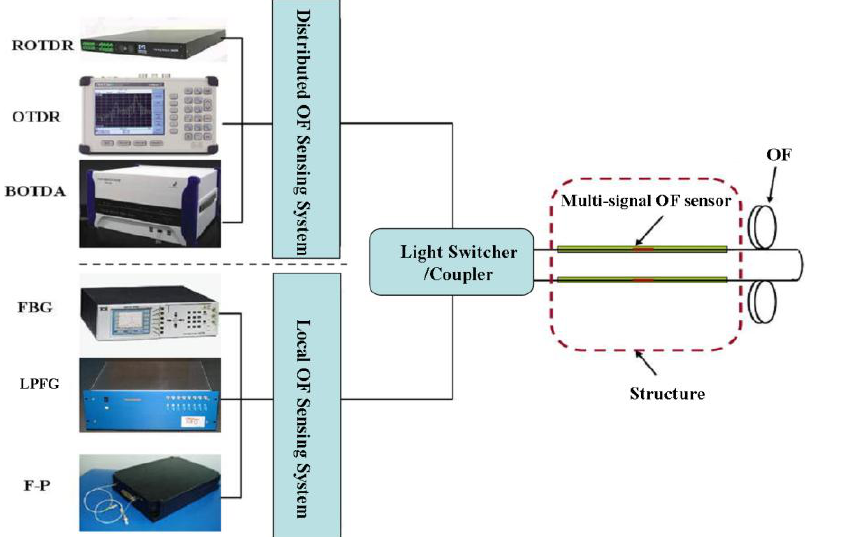
Figure 18. Schematic configuration of an OF hybrid system.